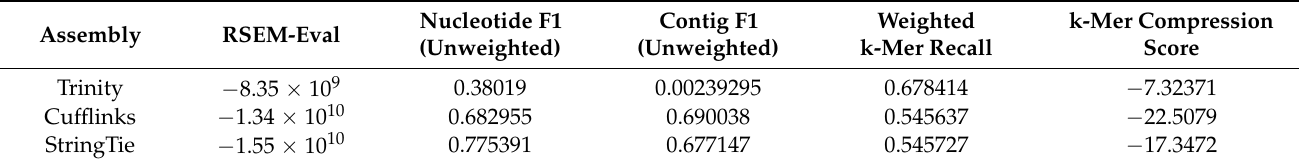
Table 5. DETONATE scores of the different Bombyx mori transcriptome